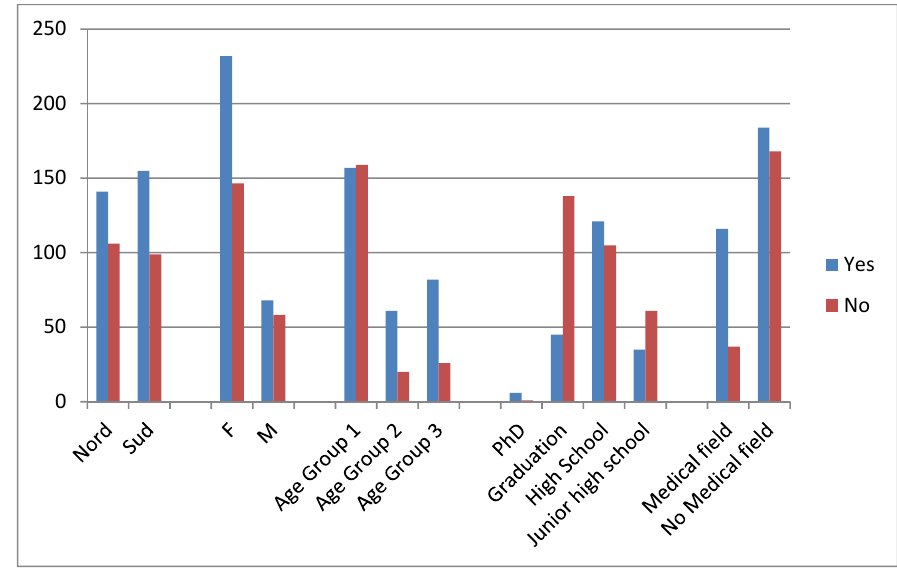
Figure 1. Answers related to knowledge of OSCC.